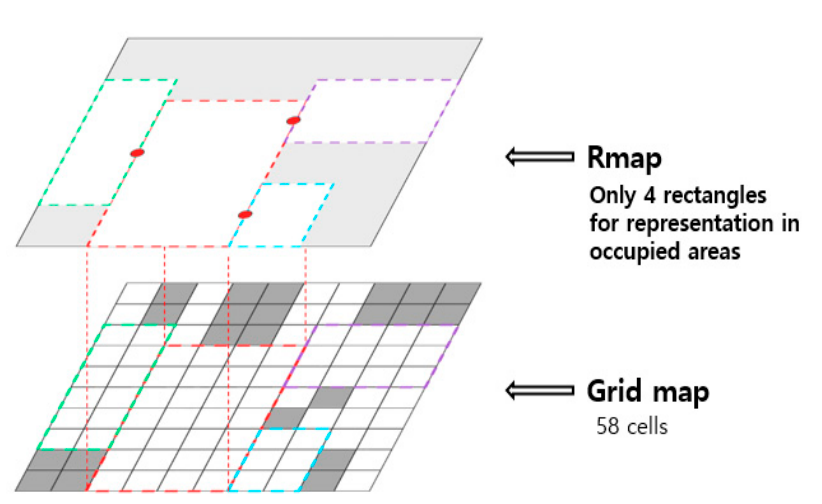
Figure 4. An example of the Rmap representation that corresponds to the grid map.